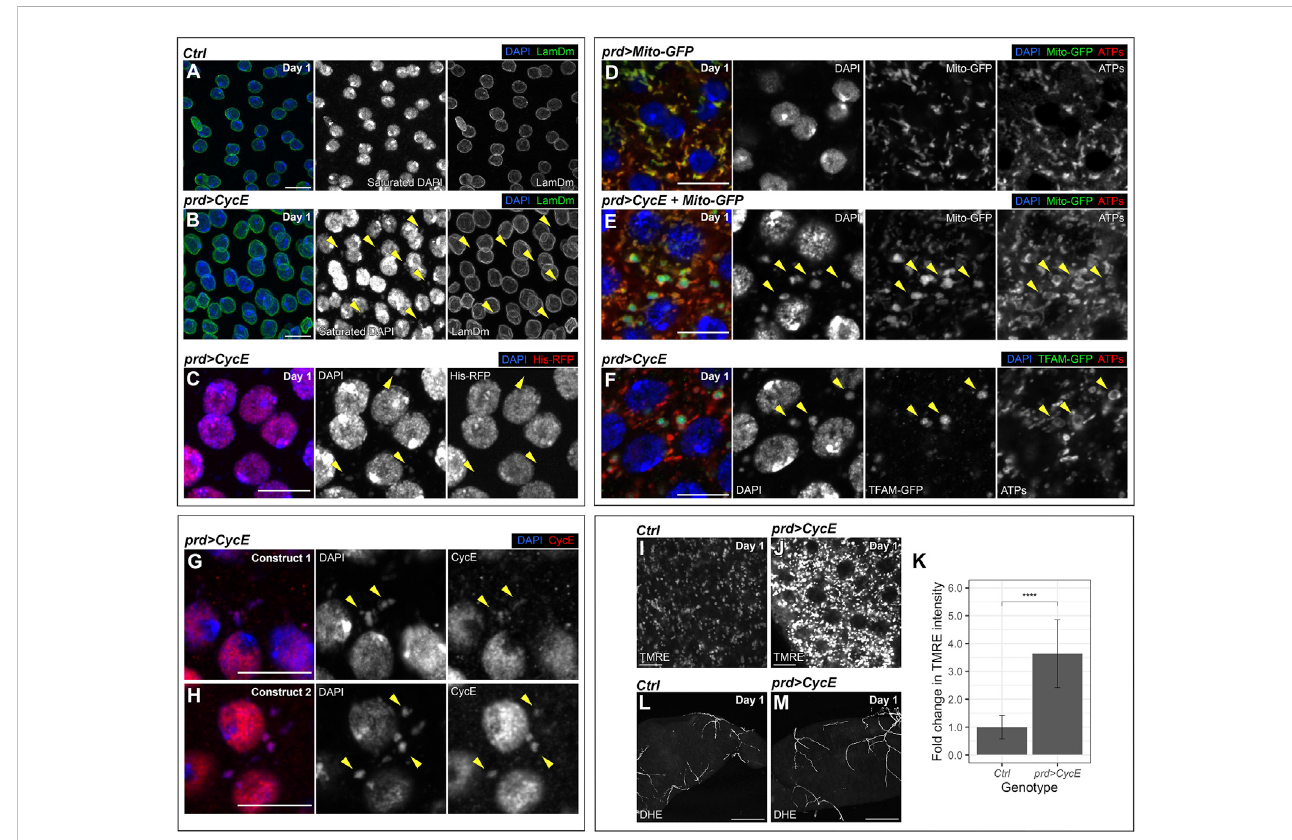
FIGURE 6 mtDNA aggregates in Cyclin E-expressing glands. (A,B) Confocal images of 1-day-old control ( prd-Gal4/+ ) (A) and prd > CycE (B) glands stained with anti-Lamin Dm. The yellow arrowheads point to examples of extranuclear DNA. DAPI and LamDm are shown in blue and green, respectively. Note that the Gal80ts system was used in this experiment. Scale bars, 10 µm. (C) Confocal image of a 1-day-old prd > CycE gland containing a transgene that expresses an RFP-taggedhistone.TheyellowarrowheadspointtoexamplesofextranuclearDNA.DAPIandHis-RFPareshowninblueandred,respectively.Notethat theGal80tssystemwasusedinthisexperiment.Scalebar,10 µm. (D,E) Confocalimagesof1-day-oldcontrol( prd > Mito-GFP ) (D) and prd > CycE+Mito-GFP (E) glands stained with anti-ATP synthase (ATPs). The yellow arrowheads point to examples of mitochondrial DNA aggregates. DAPI, Mito-GFP and ATPs are shown in blue, green, and red, respectively. Note that the Gal80ts system was used in this experiment. Scale bars, 10 µm. (F) Confocal image of a 1-day-old prd > CycE gland containing a GFP-tagged TFAM and stained with anti-GFP and anti-ATP synthase. Arrowheads point to examples of mitochondrial DNA aggregates. DAPI, TFAM-GFP and ATPs are shown in blue, green, and red, respectively. Note that the Gal80ts system was used in this experiment. Scale bar, 10 µm. (G,H) Confocalimagesof1-day-old prd > CycE accessoryglands,eachoverexpressingCyclinEfromadifferenttransgene,andstainedwithanti-CycE. Construct 1 corresponds to UAS-CycE and construct 2 corresponds to UAS-CycE-3xHA. The yellow arrowheads point to examples of mitochondrial DNA aggregates containing Cyclin E. DAPI and Cyclin E are shown in blue and red, respectively. Note that the Gal80ts system was used in this experiment. Scale bars, 10 µm. (I – K) Confocal images of 1-day-old control ( prd-Gal4/+ ) (I) and prd > CycE (J) accessory glands stained with TMRE, alongside their TMRE intensity quanti fi cation expressed as the relative fold change compared to the control (K) . In (I,J) , TMRE is shown in grays. Data shown in (K) are mean ± SD. Statistical analysis was performed using an unpaired Welch ’ s t -test. ****, p < .0001. Note that the Gal80ts system was used in this experiment. Scale bars, 10 µm. (L,M) Confocal images of 1-day-old control ( prd-Gal4/+ ) (L) and prd > CycE (M) accessory glands stained with DHE. DHE is shown in grays. Note that the Gal80ts system was used in this experiment. Scale bars, 100